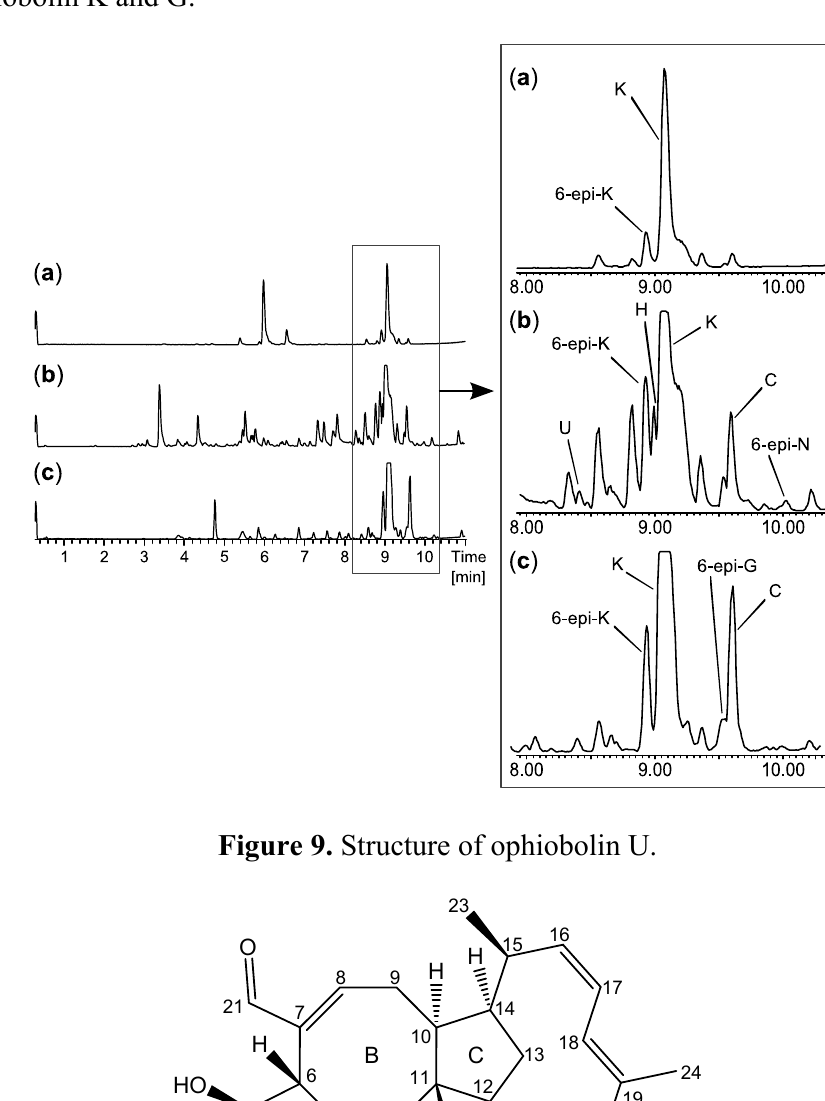
Figure 8. UHPLC chromatograms of ( a ) the new species in Aspergillus section Usti (IBT 18591) producing ophiobolin K and 6-epiophiobolin K, ( b ) A. insuetus (IBT 28266) producing the novel ophiobolin U together with ophiobolin H, K, C as well as 6-epiophiobolin K and N and ( c ) A. calidoustus (IBT 25726) producing ophiobolin K and C as well as 6-epiophiobolin K and G.